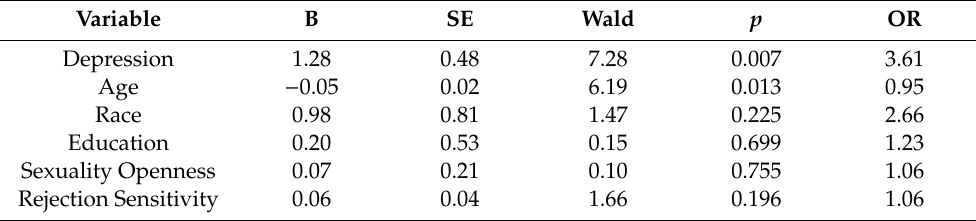
Table 5. Logistic regression analysis on the presence of anxiety